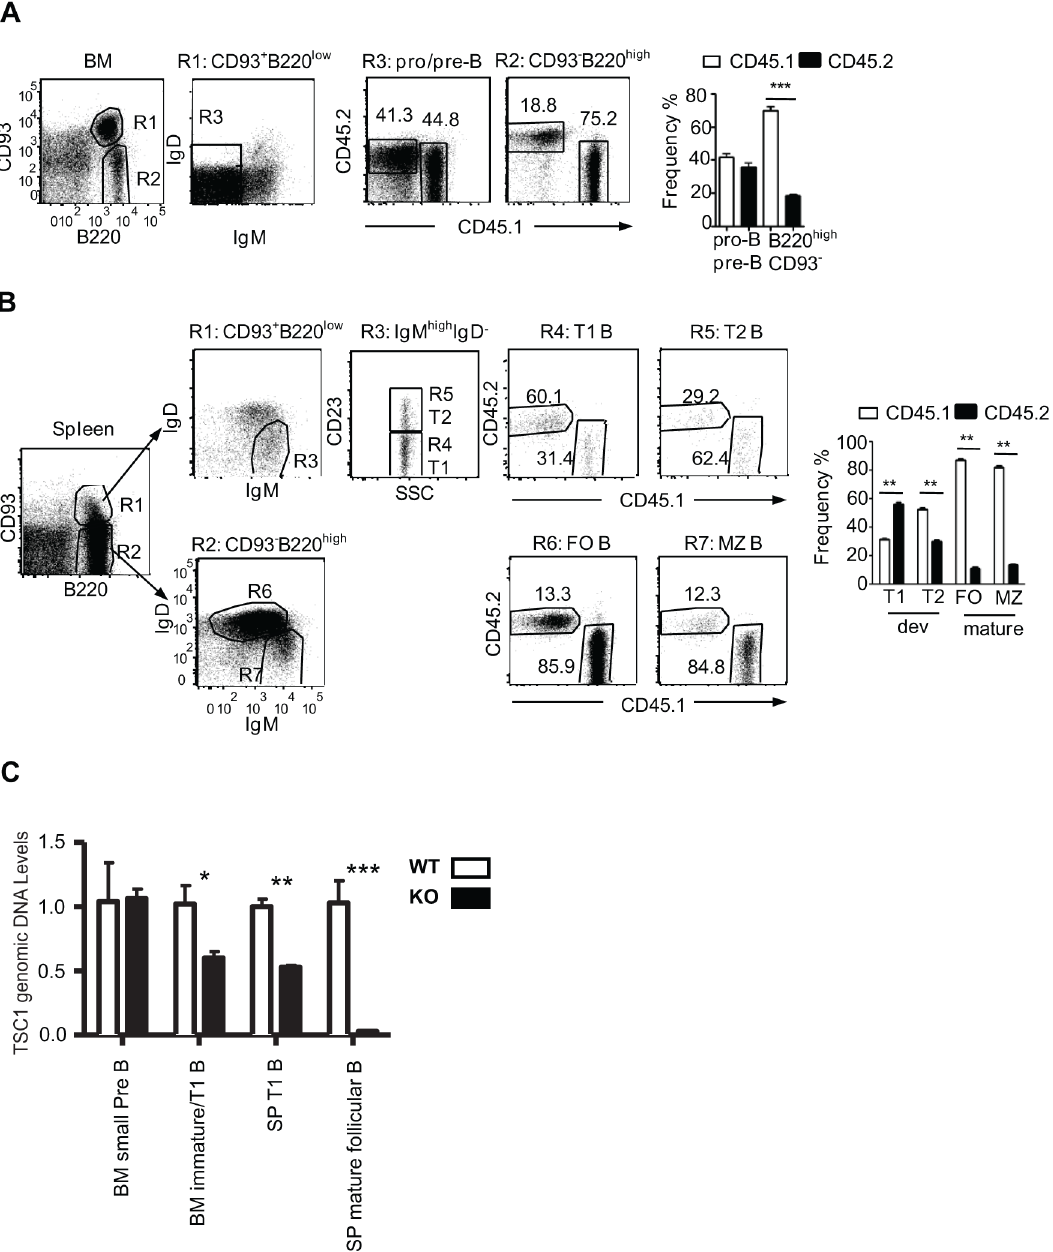
Fig 3. Accumulation of T1 B cells in TSC1KO mice is cell intrinsic. Sublethally irradiated Rag-1 -deficient mice were reconstituted with mixed CD45.1 + WT and CD45.2 + TSC1KO BM cells at 1:1 ratio. Recipient mice were analyzed similar to the method shown in Figs 1 and 2, two months after reconstitution. (A) Assessment of B cell development in the BM. Developing B cells (R1) and mature B cells (R2) in the BM were identified by B220 and CD93 expression. IgM - IgD - cells (R3) from R1-gated cells were further analyzed for CD45.1 and CD45.2 expression. Bar graph shows mean ± SEM of percentages of CD45.1 and CD45.2 positive cells in the indicated populations. (B) Assessment of B cell development in the spleen. Splenic developing (R1) and mature (R2) B cell compartments were identified by B220 and CD93 expression. T1/T2 B cells identified by R1 and R3 gating were further divided into CD45.1 + and CD45.2 + populations (top panels). Mature B cell compartment (R2) was further divided by IgM/IgD expression into mature follicular (R6) and marginal zone (R7) B cell compartments. CD45.1/CD45.2 expressions in each compartment are shown. Bar graphs are mean ± SEM of CD45.1 and CD45.2 percentages in the indicated populations (n = 4). (C) Assessment of TSC1 deletion in B cell subsets. Genomic DNA from sorted B cell subsets was used to quantify TSC1 gene in WT configuration by real-time qPCR. Bar graphs represent relative genomic DNA levels of undeleted TSC1 gene. Data shown represent or are calculated from two experiments. * p < 0.01; ** p < 0.01; *** p < 0.001.